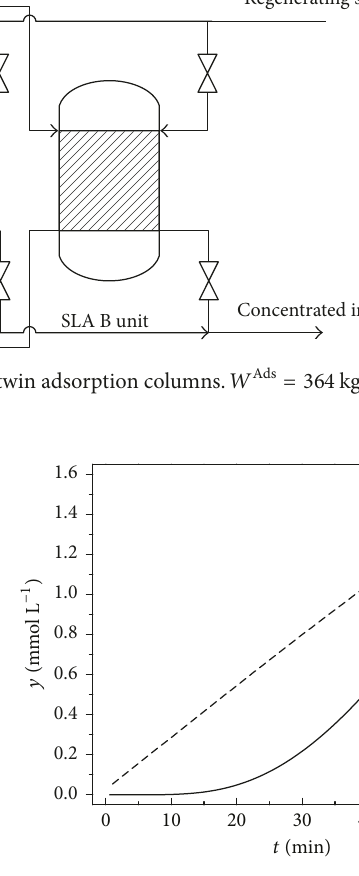
Figure 10: Adsorption column. Plot of 𝑦 (solid line) and 𝑞 (dashed line) as a function of time. 𝑊 Ads = 364 kg, 𝑄 Ext = 80 Lmin −1 , 𝑦 Ext = 7.64 mmolL −1 , 𝑞 0 = 0 mol kg −1